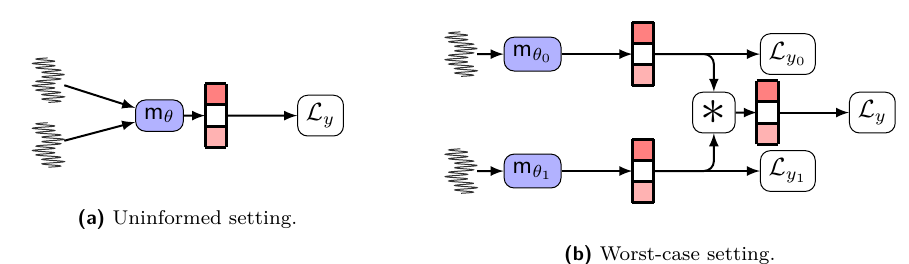
Figure 2: Other adversaries, for comparison with scheme-aware